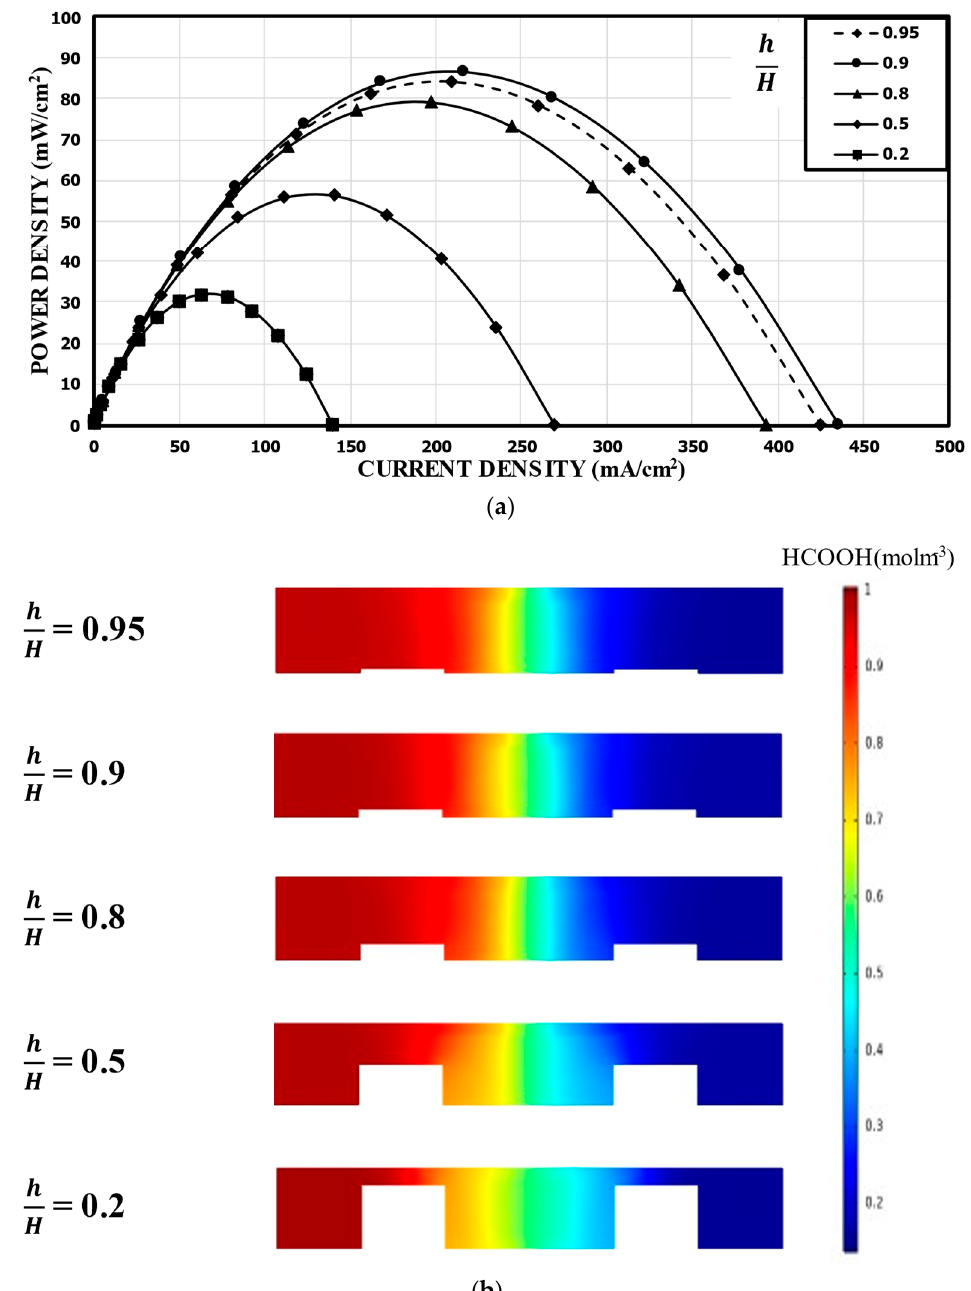
Figure 9. Effect of bridge height on the power density curve: ( a ) performance curves; ( b ) concentration contours of fuel (HCOOH) at the xz plane, 5 mm from the channel inlet.